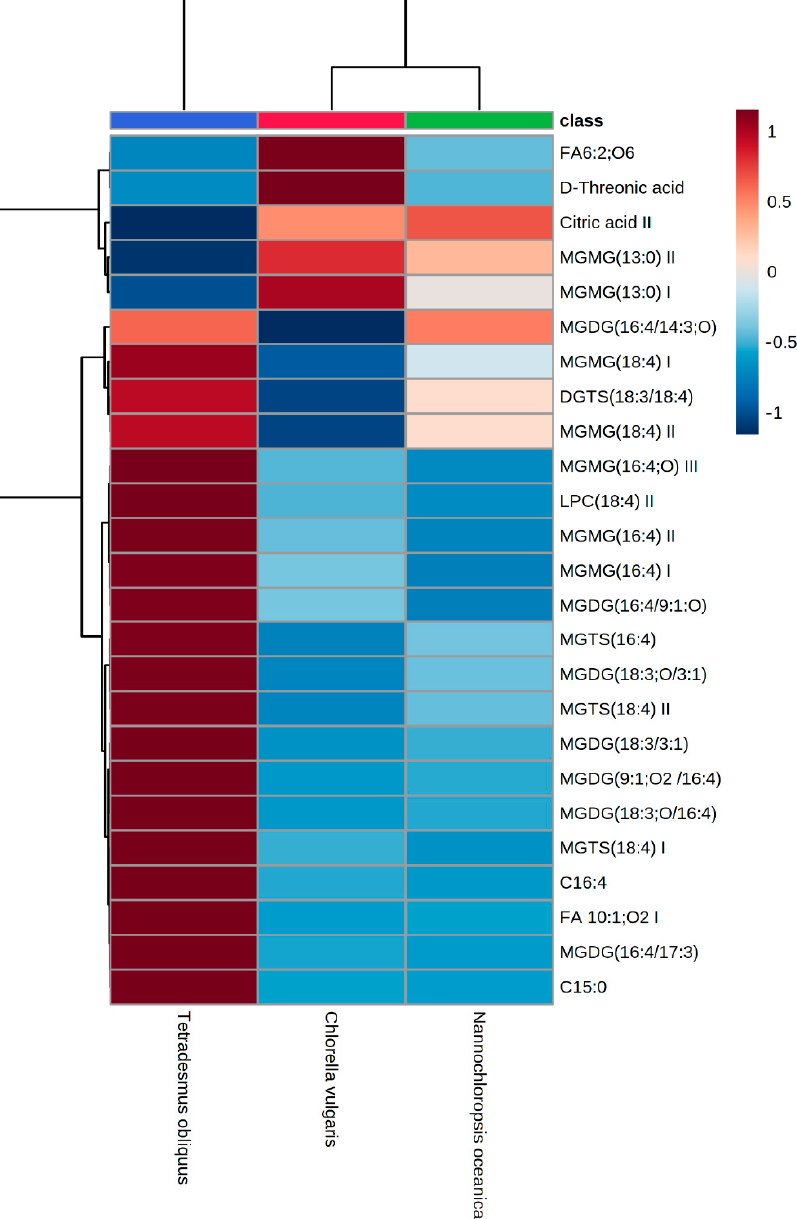
Figure 1. Heatmap showing the distribution of metabolites in the studied microalgae species con- structed using the top 25 metabolites resulting from the Partial Least Squares Discriminant Analysis, based on the variable importance in the projection score.